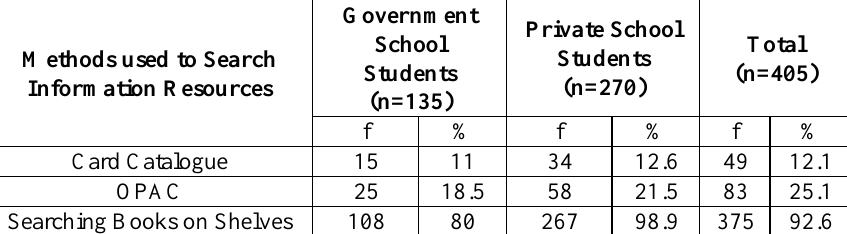
Methods used to Search Information